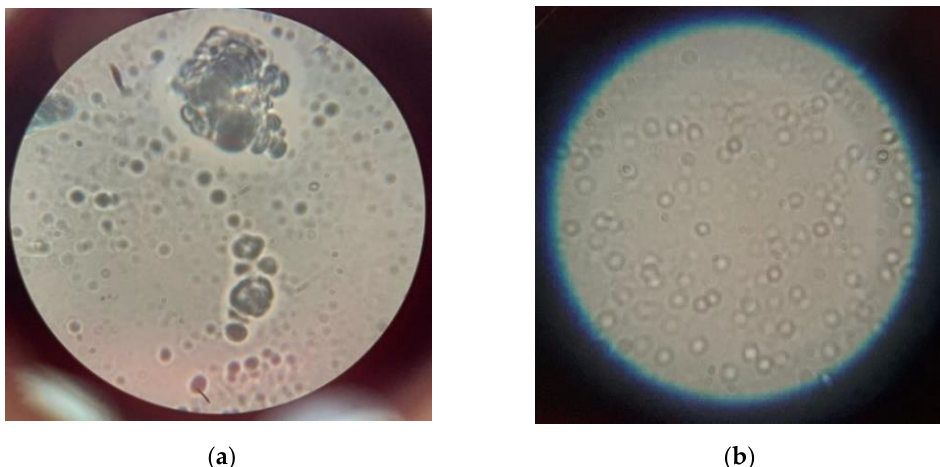
Figure 11. The geothermal water crystallization centers: ( a ) before geothermal water treatment; ( b ) after geothermal water treatment with acoustic–magnetic devices.